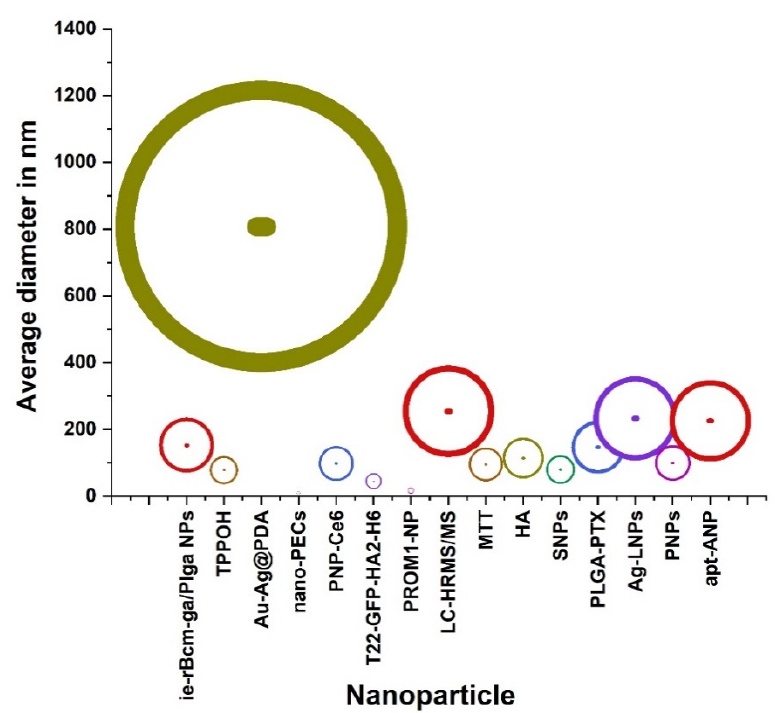
Figure 5. Average diameters of nanoparticles therapy.